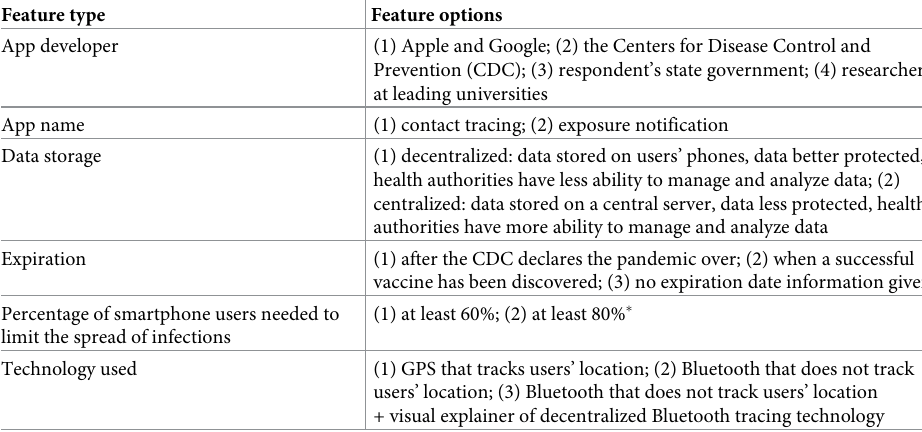
Table 1. Conjoint analysis: Features of contact tracing